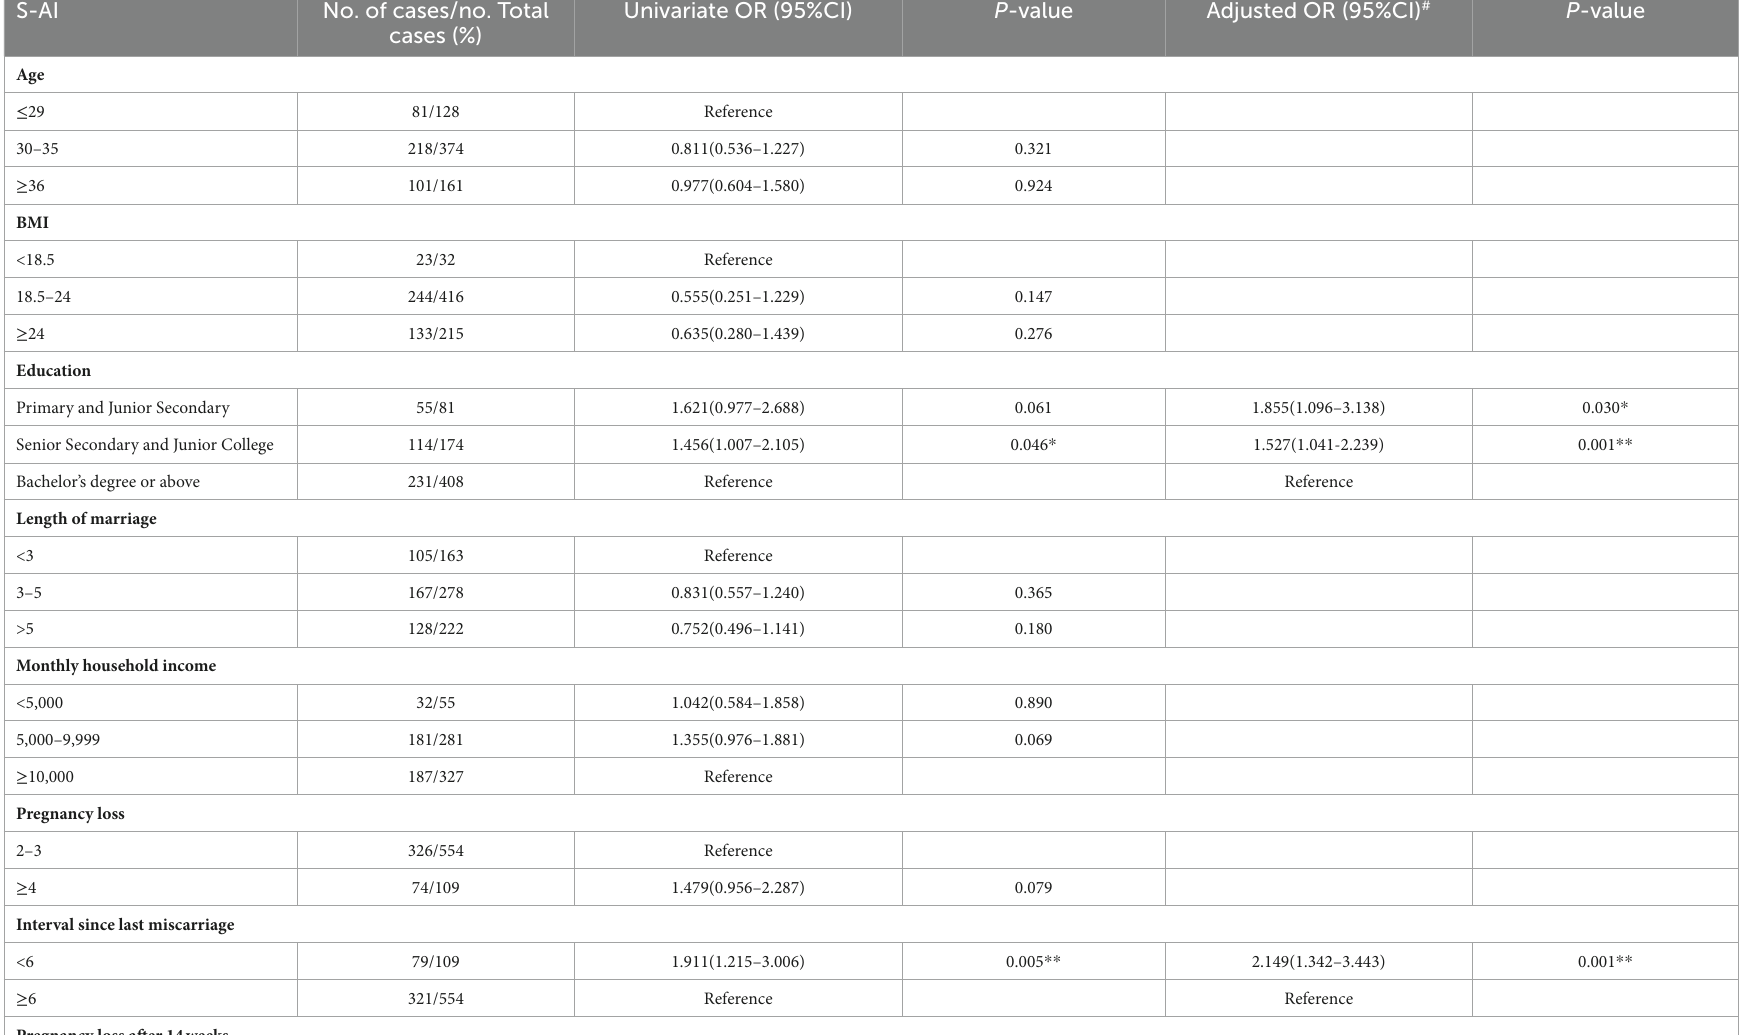
TABLE 6 Risk factors for state anxiety (S-AI scores) identified by multivariable logistic regression analysis ( n = 663).